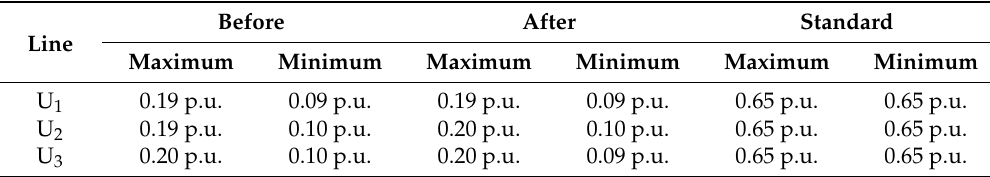
Table 5. Comparison of long duration flicker